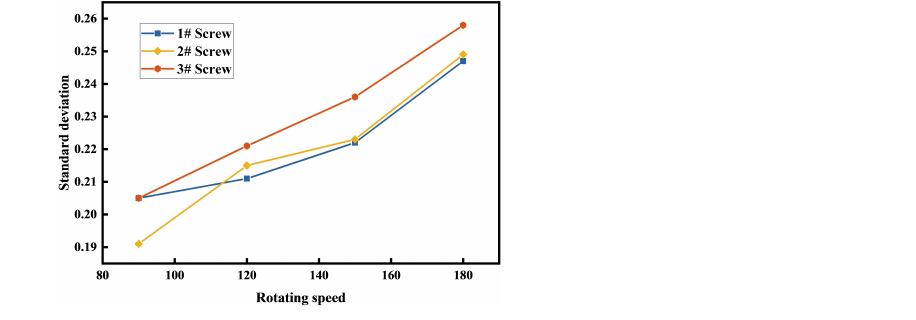
Figure 24. The standard deviation of the torque of three screws under different